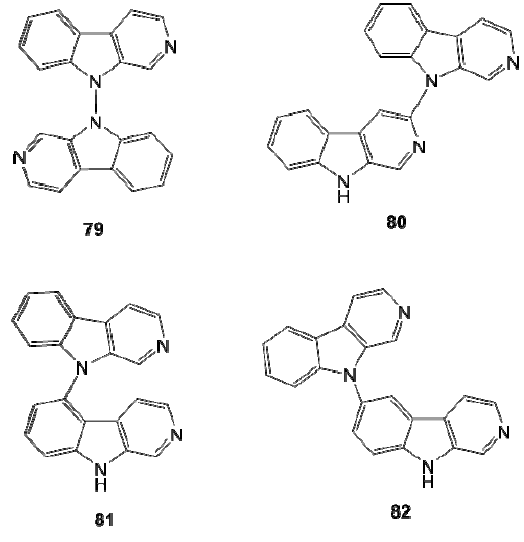
Figure 8. Symmetrical ( 79 ) and non-symmetrical ( 80–82 )  -carboline dimers.